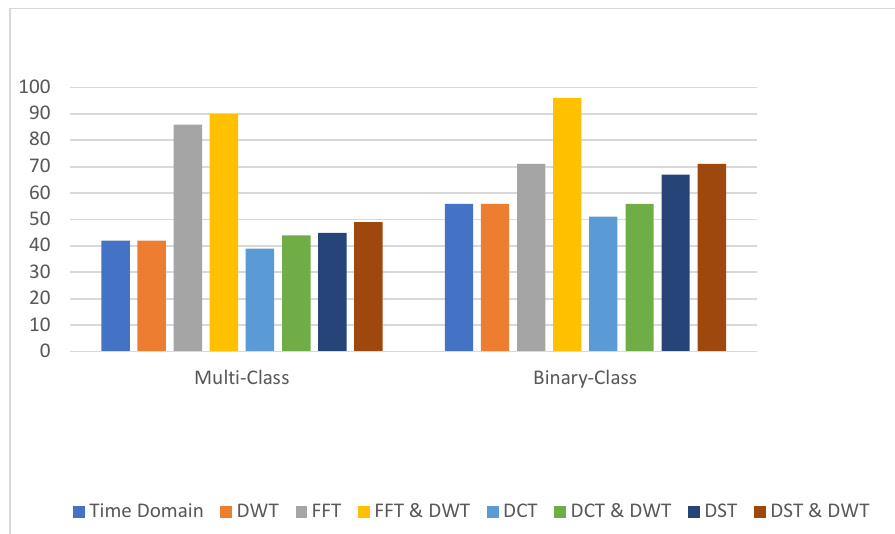
Figure 18. Brief Comparison of The Proposed System in different scenarios.